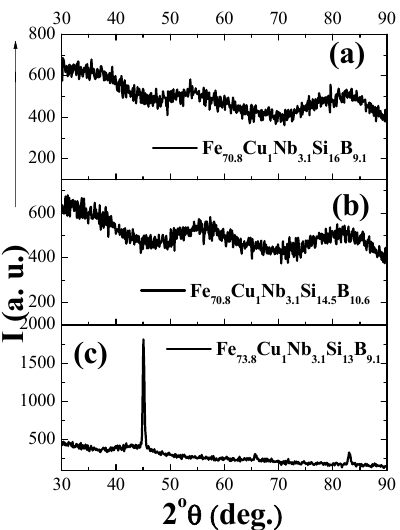
Figure 5. XRD of as-prepared Fe 70.8 Cu 1 Nb 3.1 Si 16 B 9.1 ( a ), Fe 70.8 Cu 1 Nb 3.1 Si 14.5 B 10.6 ( b ), and Fe 73.8 Cu 1 Nb 3.1 Si 13 B 9.1 ( c ) Finemet glass-coated microwires with the same ρ -ratio = 0.6. Reproduced from reference [47], Figure 2.